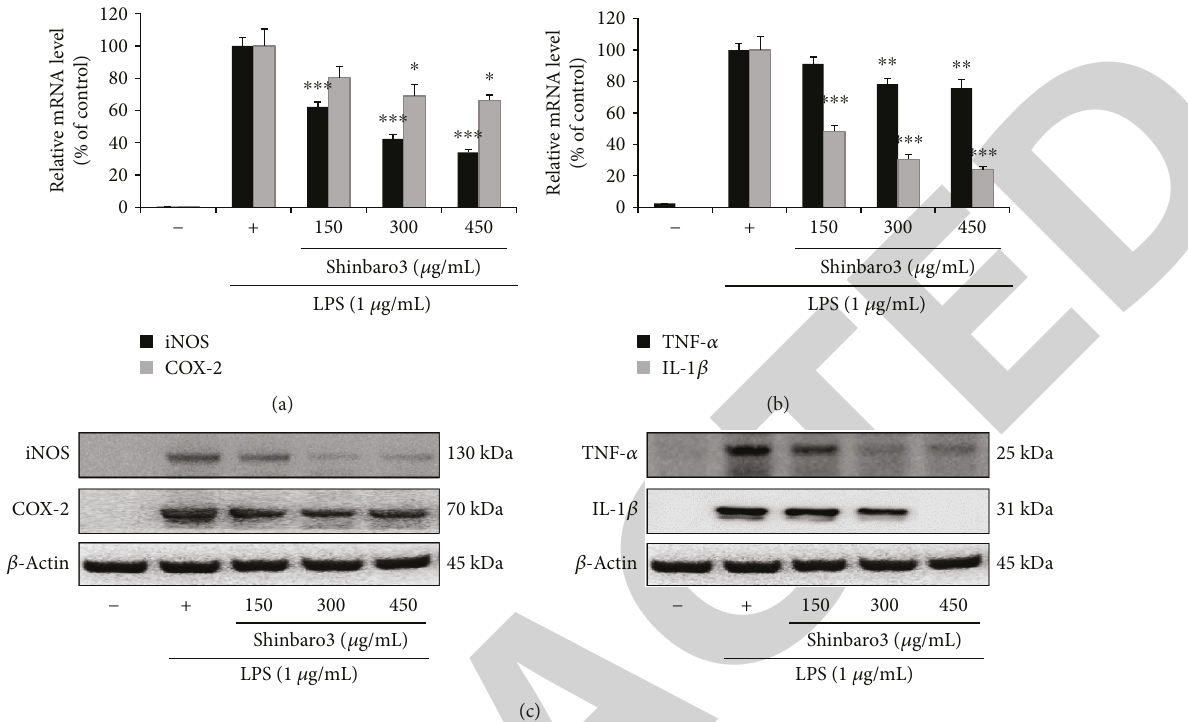
Figure 3: E ff ects of Shinbaro3 on the expression of in fl ammatory mediators in LPS-stimulated RAW 264.7 macrophage cells. RAW 264.7 cells were treated with LPS (1 μ g/mL) and Shinbaro3 (150, 300, and 450 μ g/mL) for 6 h to investigate mRNA expression (a, b) or 18h to investigate protein expression (c). iNOS, COX-2, TNF- α and IL-1 β mRNA, and protein expression levels were then analysed in real-time RT-PCR and Western blot assays, respectively. The results were normalized using β -actin as an internal control. Data are presented as the mean ± SD ( n = 3 ). ∗ p < 0 05 , ∗∗ p < 0 01 , and ∗∗∗ p < 0 001 versus LPS treatment